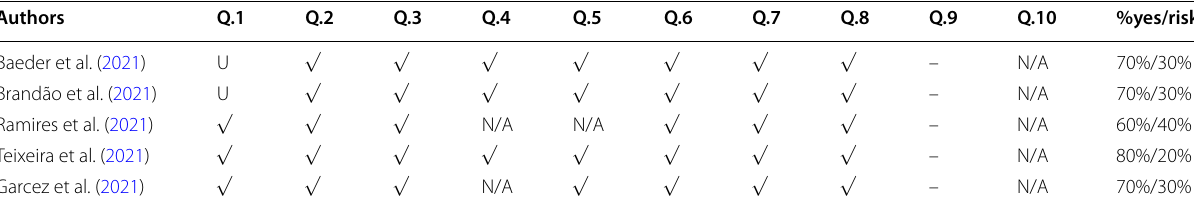
Table 3 Risk of bias assessed by the Joanna Briggs Institute Critical appraisal checklist for case series